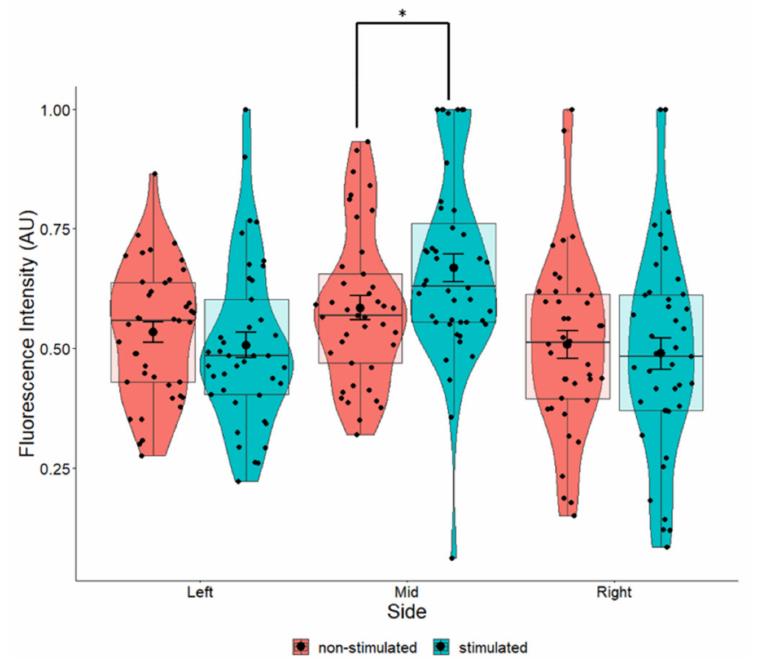
Figure 11. Pair-wise comparison of BDNF expression in SH-SY5Y cells with and without ES grown in relation to the position of the EF (based on Figure 3). One-way ANOVA p = 0.405 ( left ) p = 0.035 ( middle ) p = 0.672 ( right ). The most significant changes in BDNF expression were seen in cells found at the center of the EF. Left n = 82, middle n = 82, right n = 81. * p <